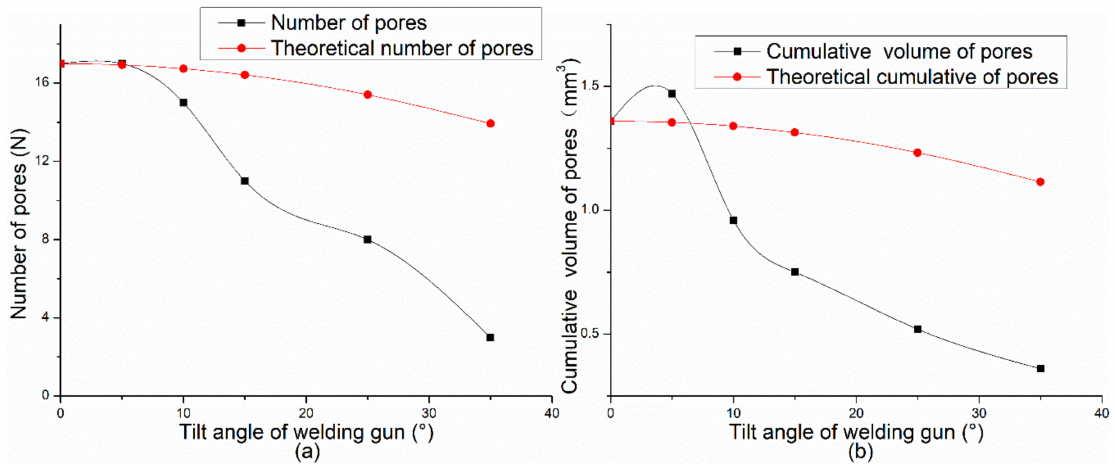
Figure 6. ( a ) Calculation and actual curve of the pore number and ( b ) calculation and actual curve of the pore total